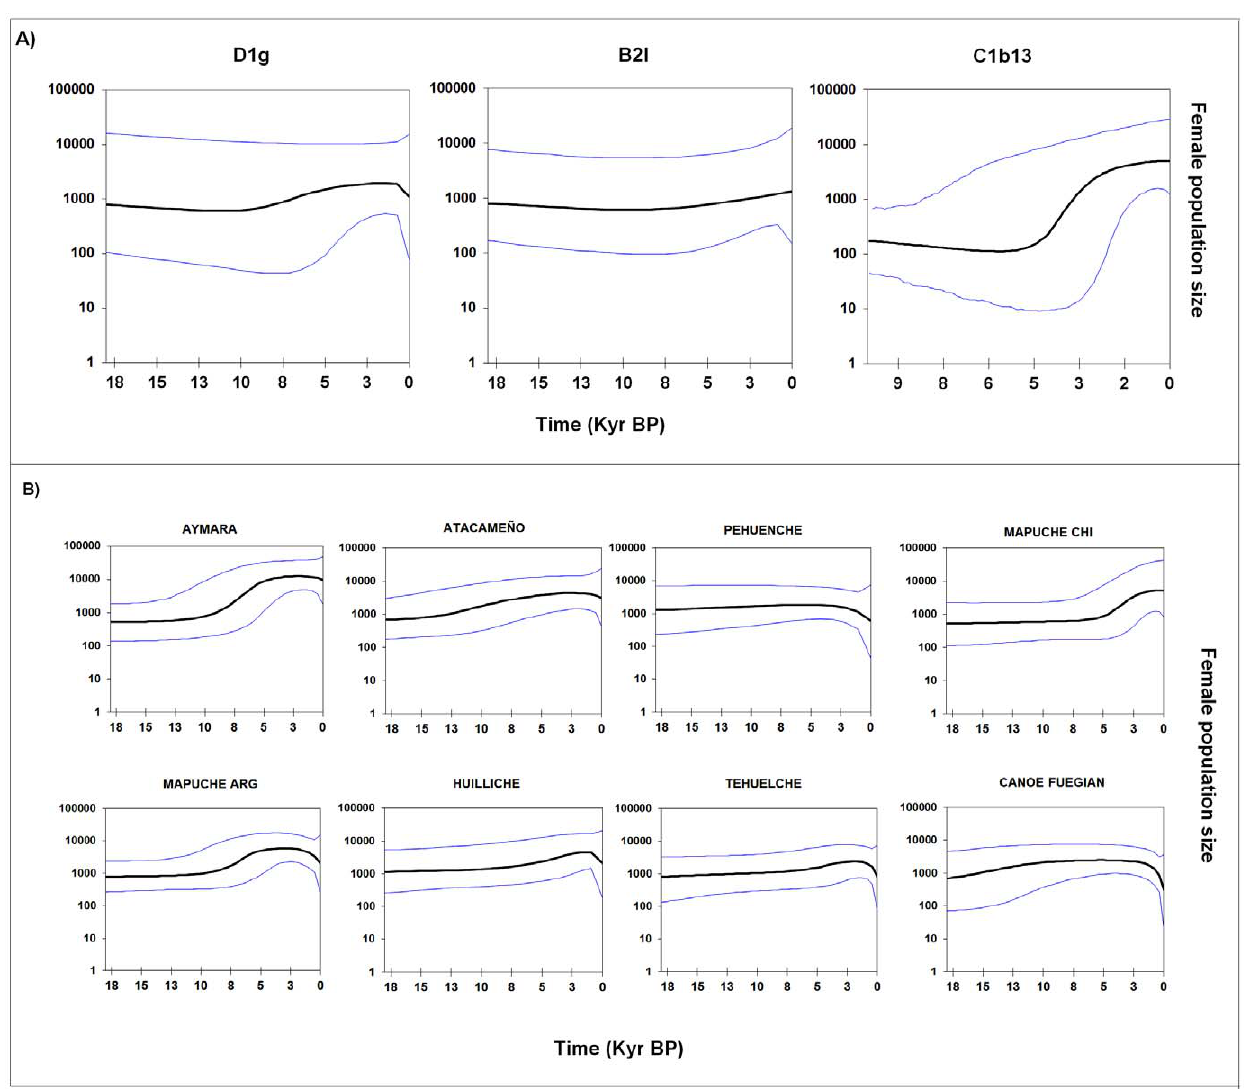
Figure 5. Bayesian Skyline Plot (BSP) showing effective population sizes over time derived from mtDNA D-loop sequences. A) Southern Cone specific haplotypes. B) By ethnic group.